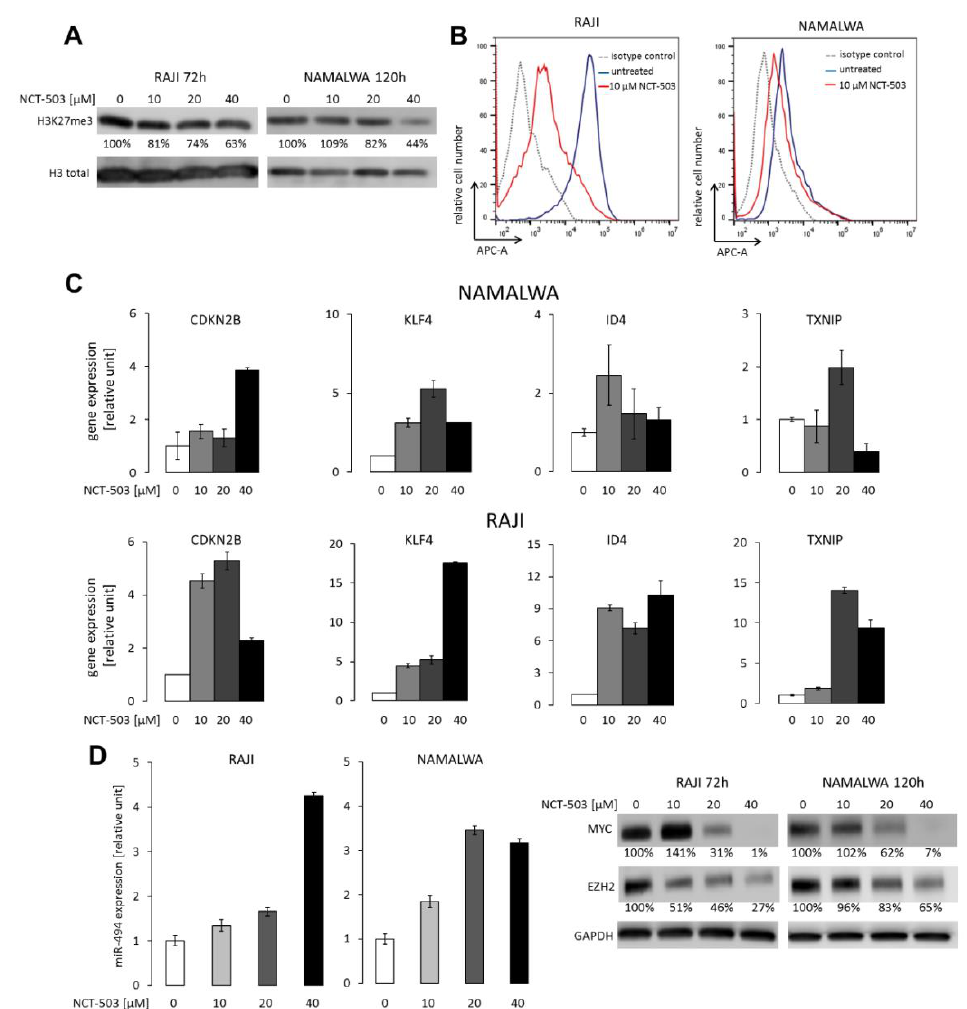
Figure 5. PHGDH inhibition with NCT-503 a ff ects histone H3 and DNA methylation, causes re-expression of tumor suppressor genes, and decreases MYC and EZH2 levels. ( A ) Decreased H3K27me3 after 96 and 120 h incubation with NCT-503 in RAJI and NAMALWA, respectively. Representative Western blot of 3 independent experiments with densitometry (% of control) is shown. Histone H3 was used as a loading control. ( B ) NCT-503 decreases global DNA methylation. RAJI and NAMALWA cells were incubated with 10 µ M NCT-503 for 72 h, then stained for 5-methylcytosine and analyzed with flow cytometry. Representative histograms of three independent experiments are shown. ( C ) Chemical inhibition of PHGDH restores the expression of tumor suppressor genes in RAJI and NAMALWA. Cells were incubated with di ff erent doses of NCT-503 (10–40 µ M, 72 h). Thereafter, mRNA abundance of CDKN2B, KLF4, ID4, and TXNIP was assessed using RQ-PCR. ( D ) Chemical inhibition of PHGDH with NCT-503 induces miR-494 expression and leads to decreased EZH2 and MYC protein levels. The expression of miR-494 was assessed using RQ-PCR. In ( C ) and ( D ), bars indicate means ± SD from a representative of three independent experiments performed in